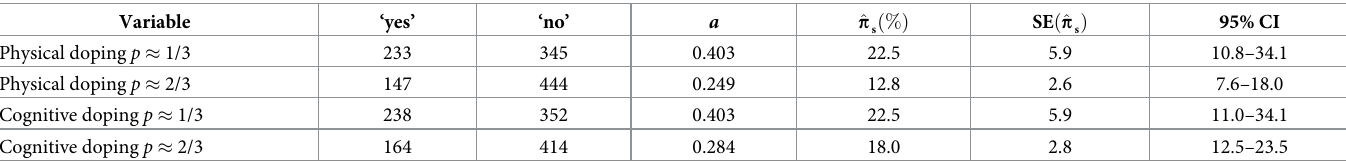
Table 4. Estimated 12-month prevalences for physical and cognitive doping using the UQM for p (cid:25) 1/3 and p (cid:25) 2/3 (cid:3) . Variable ‘yes’ ‘no’ a ^ π